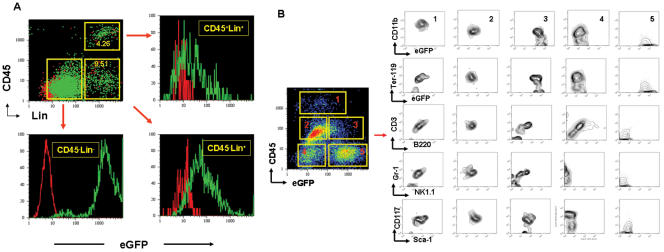
Phenotypic alterations of pCSCs progressing to cancer.Single tumor cells were either prepared and freshly stained with mAb to CD45 and a mixture of lineage-specific mAbs to CD3, CD11b, Ter-119, Gr-1 and B220 (A) or cultured for 2 d and stained with mAb to CD45 in combination with mAbs to lineage markers or to c-kit and Sca-1 as indicated (B). The samples were analyzed by three- (A) or four-color flow cytometry (B). The green and red dot plots or histograms represent, respectively, the tumor cells derived from eGFP+ 2C4G2 (green) and eGFP− 2C4 (red) cells (A). Five populations (p1∼5) of tumor cells are identified based on the level of CD45 and eGFP expression (B).